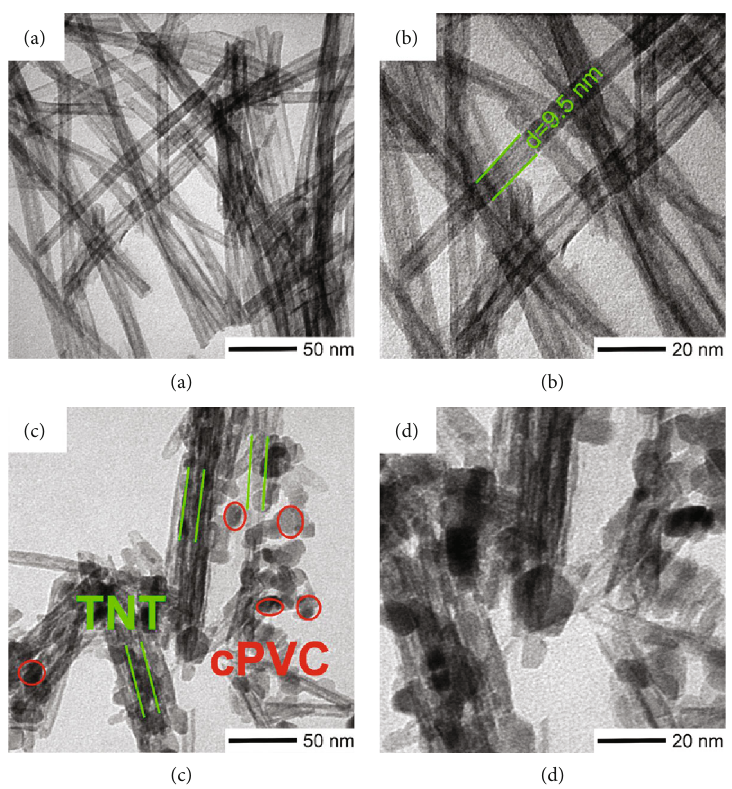
Figure 2: TEM image of (a, b) TNTs and (c, d) cPVC/TNT